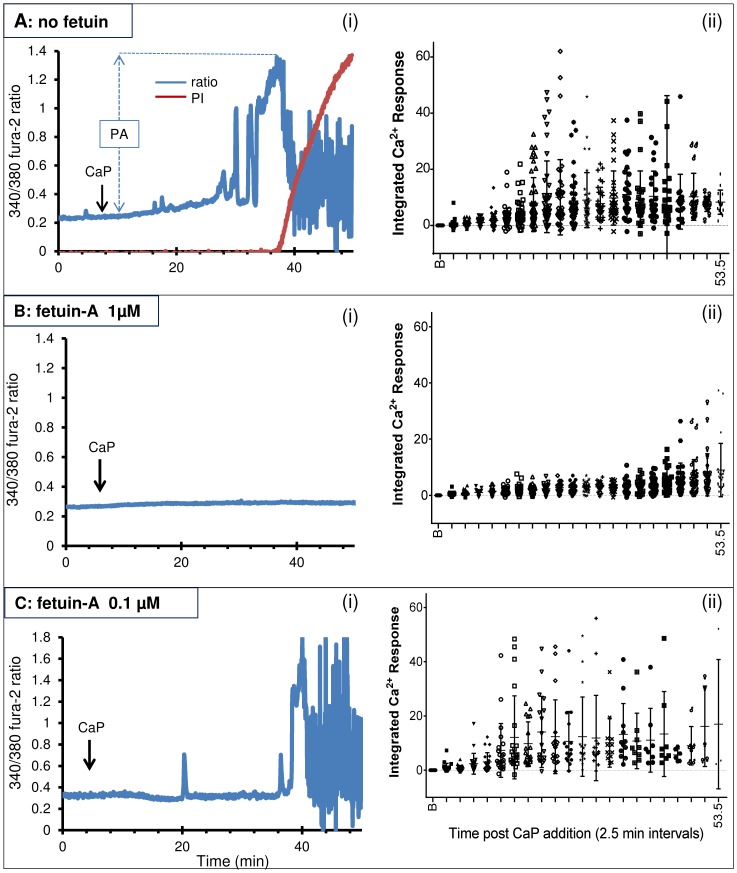
Effects of CaP particles on intracellular Ca2+ in the presence and absence of fetuin-A.Experiments were conducted either in the absence of fetuin-A (A), with 1 µM fetuin-A (B) or 0.1 µM fetuin-A (C). A-C(i) are representative traces showing intracellular Ca2+ changes in individual fura-2-loaded VSMCs on addition of 25 µg/mL CaP particles (arrow). A(i) Peak amplitude (PA) is indicated after addition of CaP particles. Note that fura-2 loss coincided with PI uptake, indicating time of cell death. Intracellular Ca2+ changes seen after cell death did not correspond to genuine Ca2+ signals (also explained in Fig. 3A and B). Incubation with 1 µM fetuin-A (B(i)) but not 0.1 µM fetuin-A (C(i)) silenced intracellular Ca2+ activity and prevented cell death. A-C(ii) Summary of intracellular Ca2+ activity in all VSMCs used for each condition. Each dot represents the area under the curve calculated for each 2.5 minute interval post CaP particle addition from individual cells. ‘B’ on the x-axis of these graphs represents the baseline, or 2.5 minutes prior to addition of CaP particles. These graphs display the range and magnitude of intracellular Ca2+ elevations after CaP particle addition from several individual experiments and also show that after addition of 1 µM fetuin-A, Ca2+ activity was vastly reduced and delayed (B(ii)).